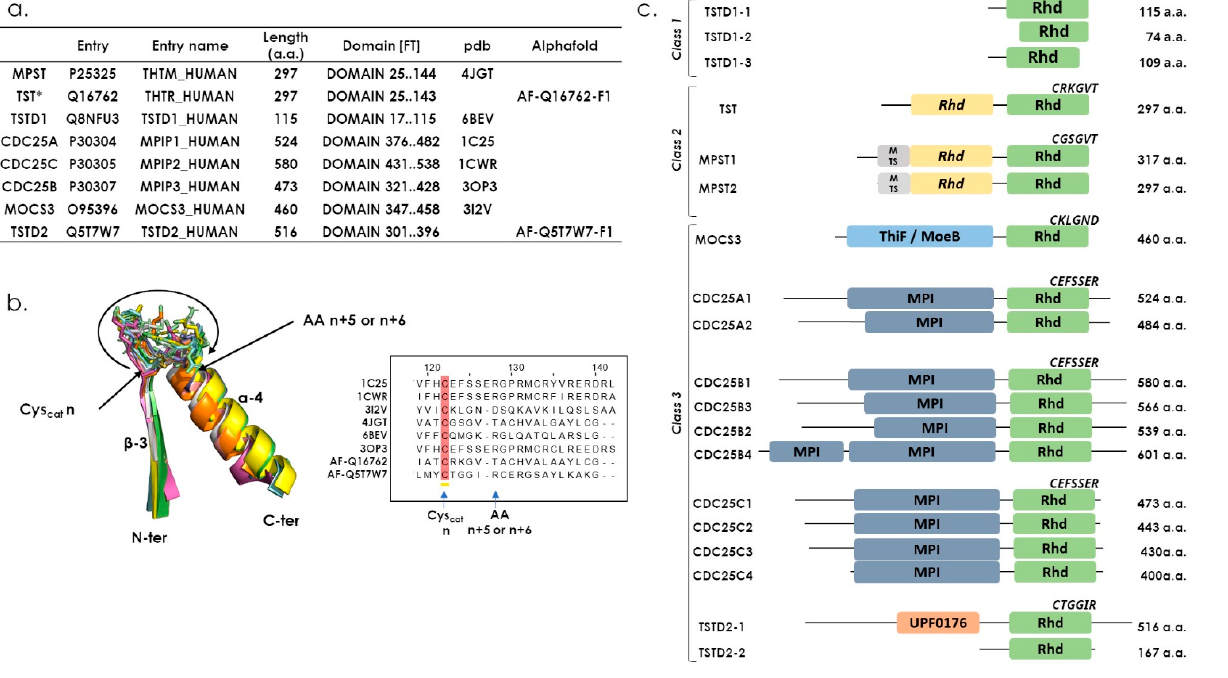
Figure 4. Reported sub-cellular localizations of human Rhd-containing proteins representatives [24,26–34].